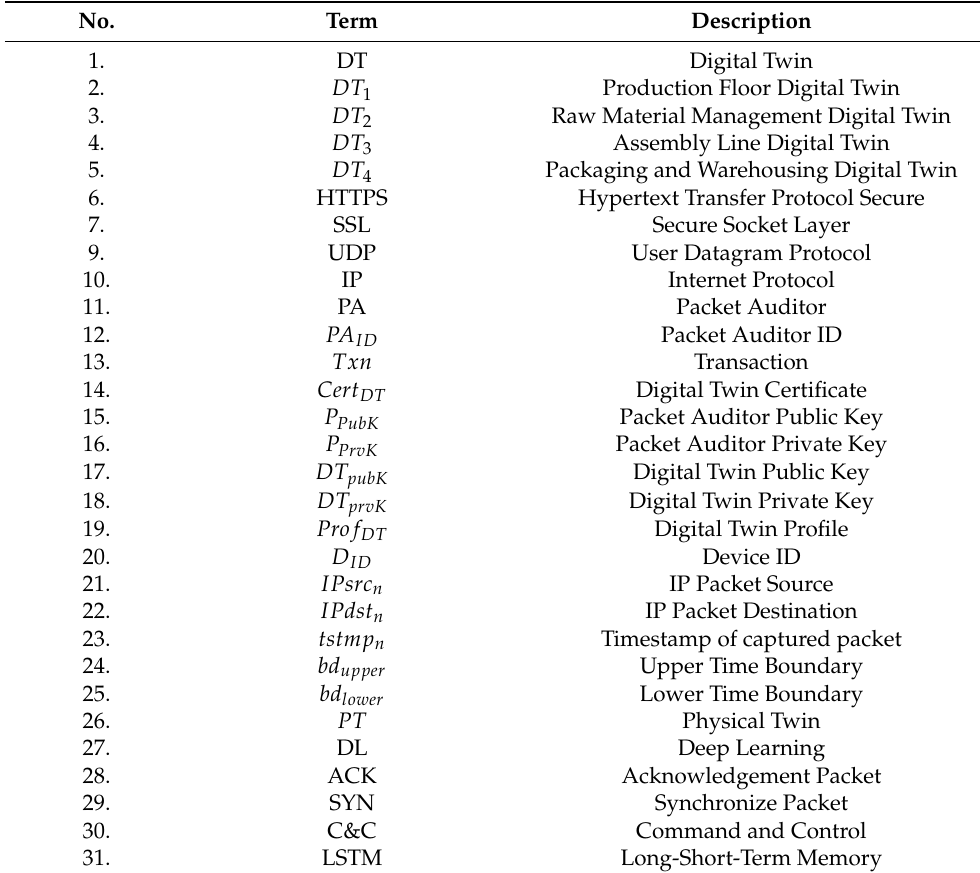
Table 2. Notation table for abbreviations used in the framework.